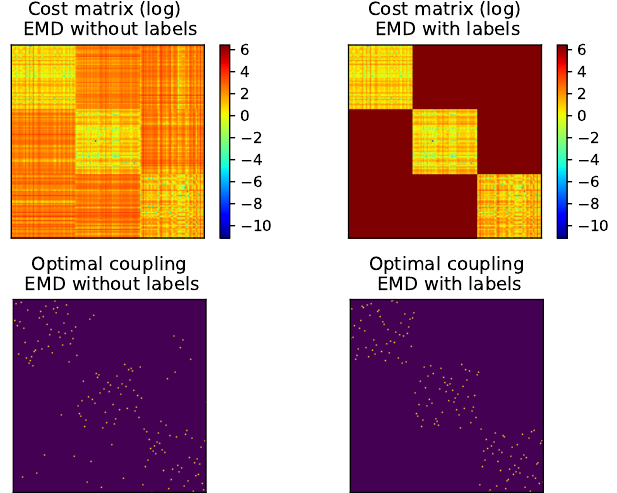
Figure 2. Cost and coupling matrices. The left column shows the EMD standard use and the right column, the use of labels from both domains. The used data are simulated using Gaussian distributions with only three classes. For a better visualization of the cost values, a logarithmic scale was used. Depending on the algorithm, using the labels of the two domains does not have the same